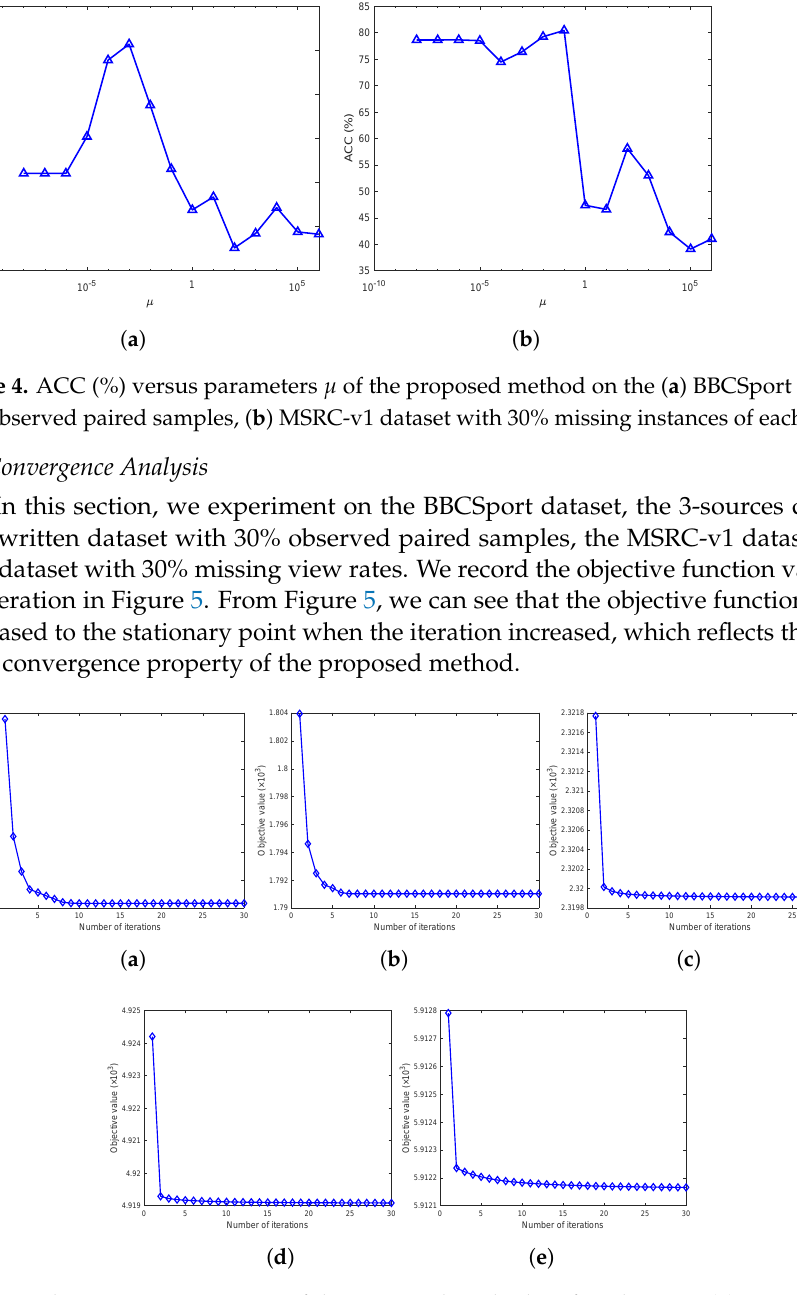
Figure 5. The convergence curves of the proposed method on five datasets: ( a ) BBCSport dataset, ( b ) 3-sources dataset, ( c ) handwritten dataset with 30% observed rates of paired samples, ( d ) MSRC-v1 dataset, and ( e ) ORL dataset with 30% missing view